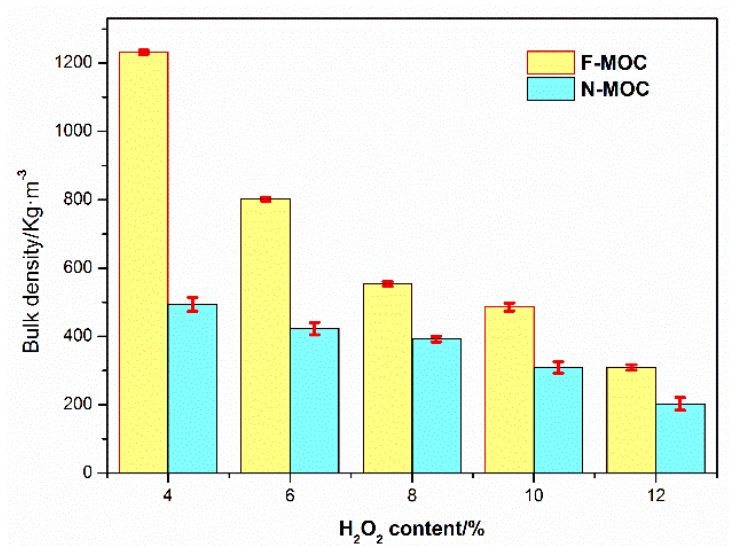
Figure 1. Comparison of foamed magnesium oxychloride cement (F-MOC) and magnesium oxychloride cement without 2H-tridecylfluoro-n-octylsilane (FAS) or tetraethylorthosilicate (TEOS) (N-MOC) bulk density under different H 2 O 2 content (FAS content was fixed at 1% of the mass of MgO; TEOS was added according to the molar ratio of FAS to TEOS of 1:6).